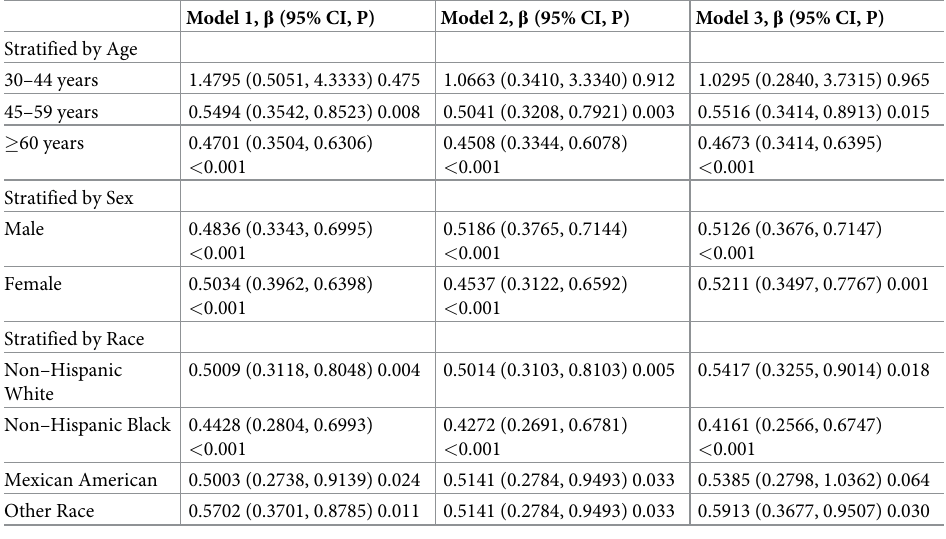
Table 3. Asociation between serum albumin(g/dl) and stratified by age, sex, and race. Model 1, β (95% CI,